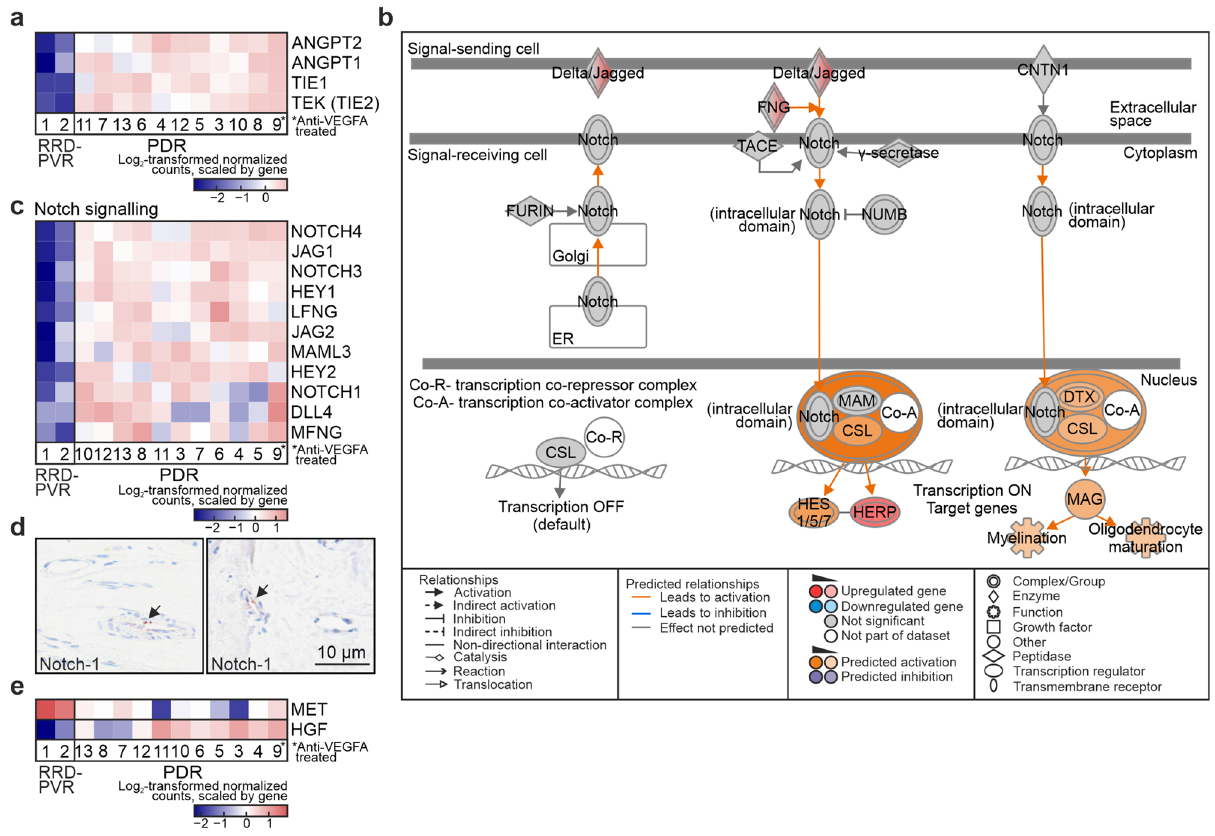
Figure 4. VEGFA-ligand-independent mechanisms are involved in proliferative diabetic retinopathy. ( a ) Heatmap of log 2 -transformed normalized read counts of ANGPT1, ANGPT2, TIE1 and TIE2. ( b ) IPA canonical pathway Notch signalling . ( c ) Heatmap of log 2 -transformed normalized read counts of DEGs in Notch signalling . ( d ) Representative light micrographs of immunohistochemistry for Notch-1 in PDR fibrovascular tissue. Scale bar, 10 µm. ( e ) Heatmap of log 2 -transformed normalized read counts of MET and HGF. Asterisk in ( a ), ( c ) and ( e ) indicate the anti-VEGFA-treated PDR patient (Patient 9). The pathway in ( b ) was generated through the use of IPA (QIAGEN Inc., https:// www. qiage nbioi nform atics. com/ produ cts/ ingen uity- pathw ay- analy sis) 45